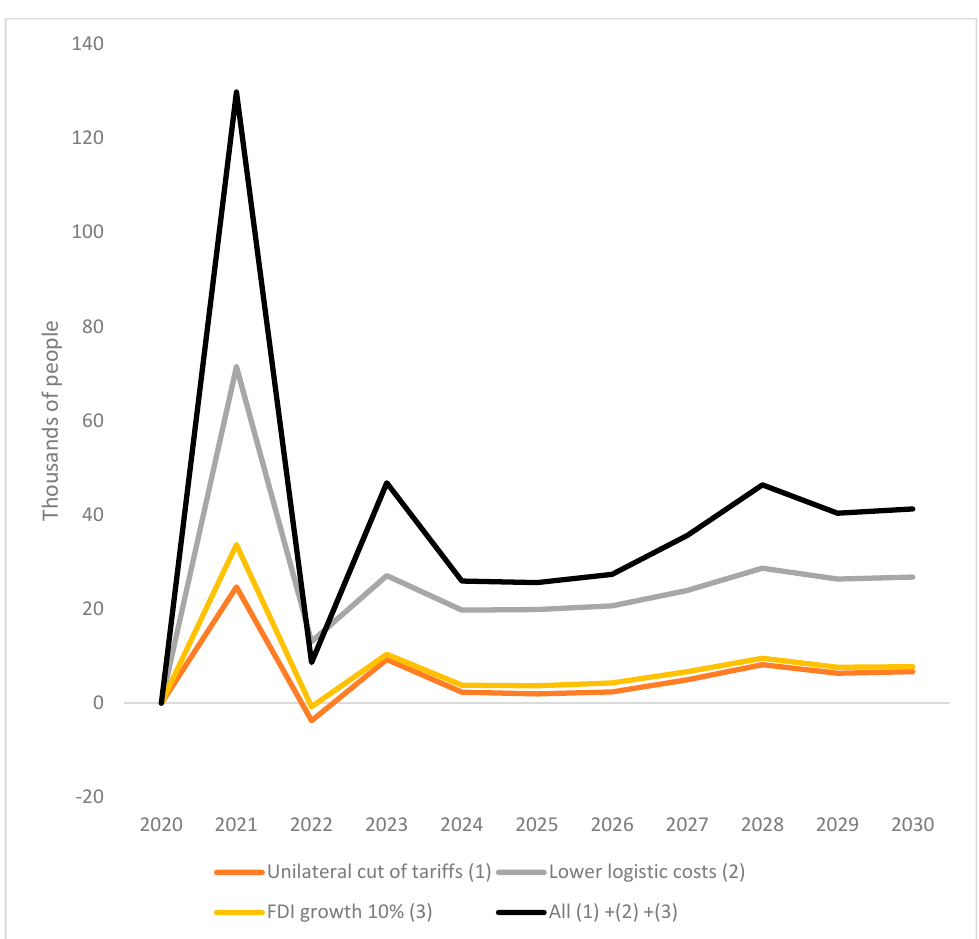
Figure 8. Employment Generation from JET Reforms. Source: Authors’ calculations.